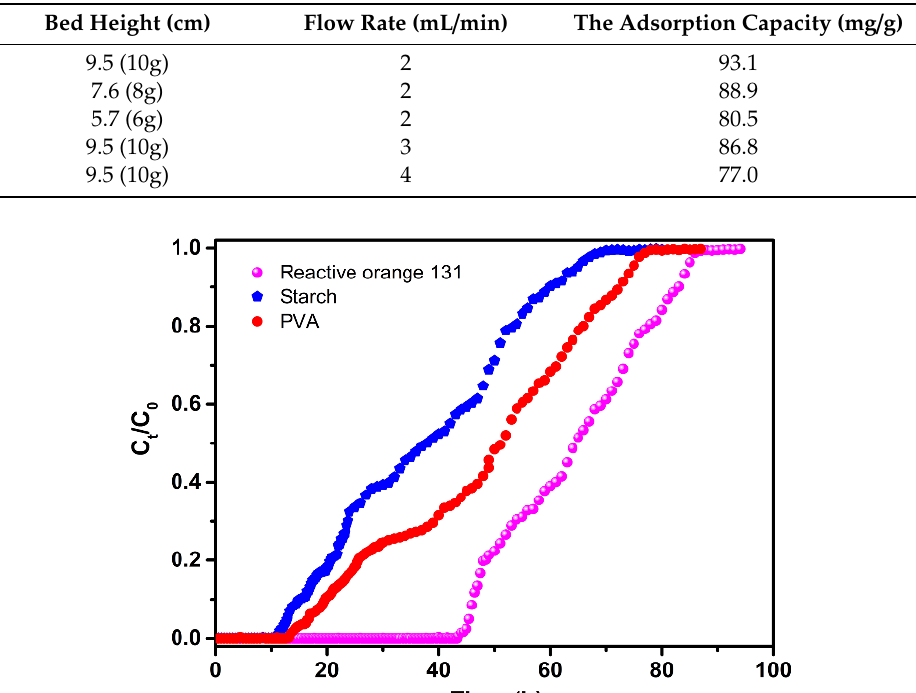
Figure 7. Breakthrough curves in the fixed-bed column. Experimental operating conditions: the mixture adsorbent composed of CCSP2 and AC (mass ratio of 1:1; 10 g), flow rate = 2 mL/min.